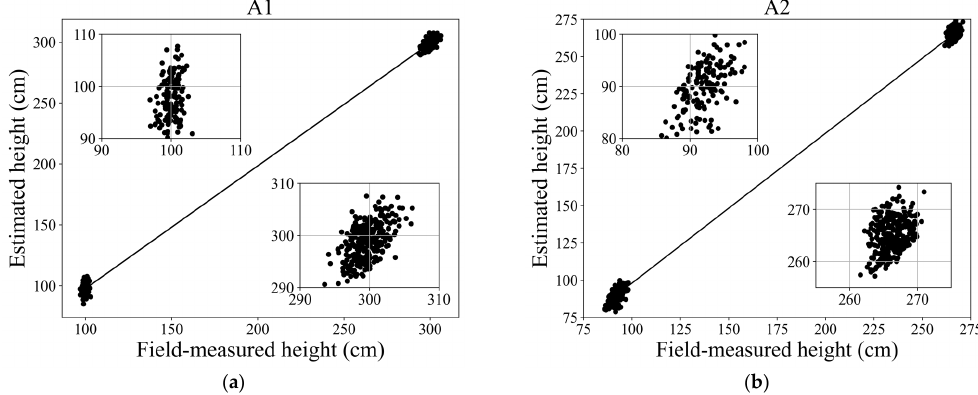
Figure 15. Scatter plots of field-measured heights versus estimated heights during the entire growth period: ( a ) A1, ( b ) A2. period: ( a ) A1, ( b )